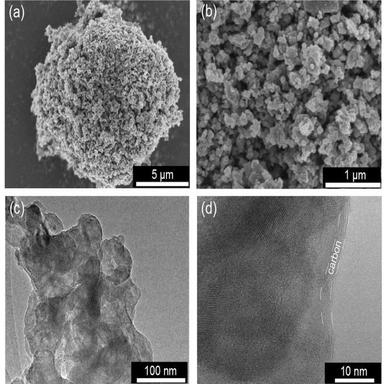
(a, b) SEM images of LMB/BxOy@C under different magnifications. (c, d) Low- and high-magnification TEM images of LMB/BxOy@C.